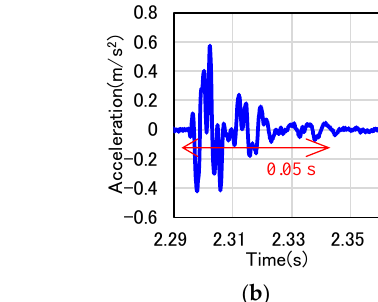
Figure 5. Example of the time-history waveform of the excitation force and the acceleration in the ballast (ballasted ladder track): ( a ) excitation force; ( b ) vertical acceleration measured in the ballast.